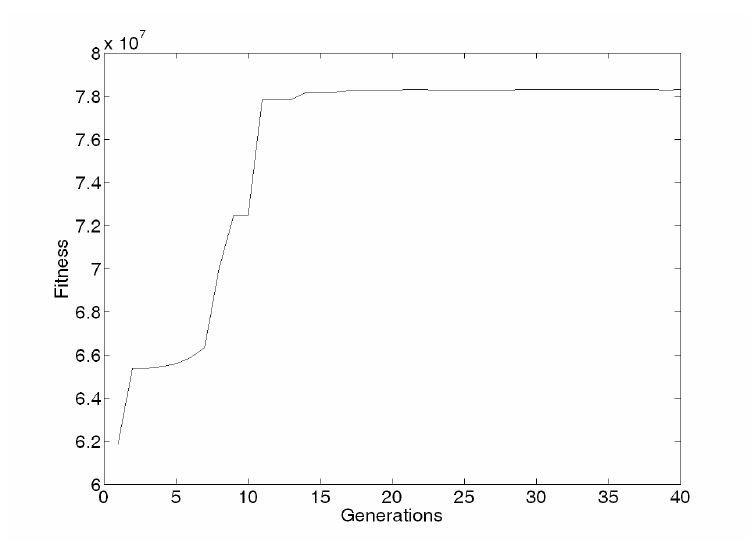
Fig. 10. Evolution of the best-so-far fitness vs. generation, during the overall